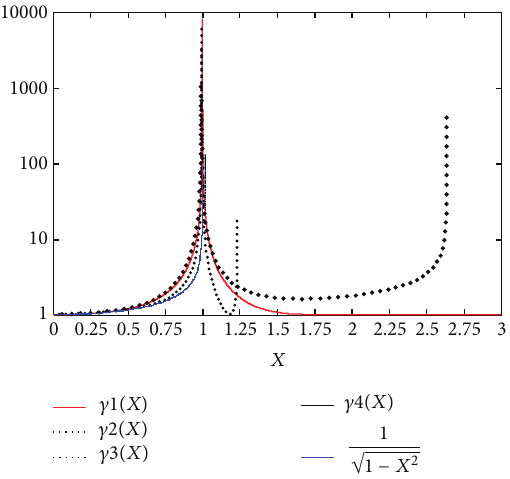
Figure 1: Four realizations of the 𝛾 function versus V /𝑐